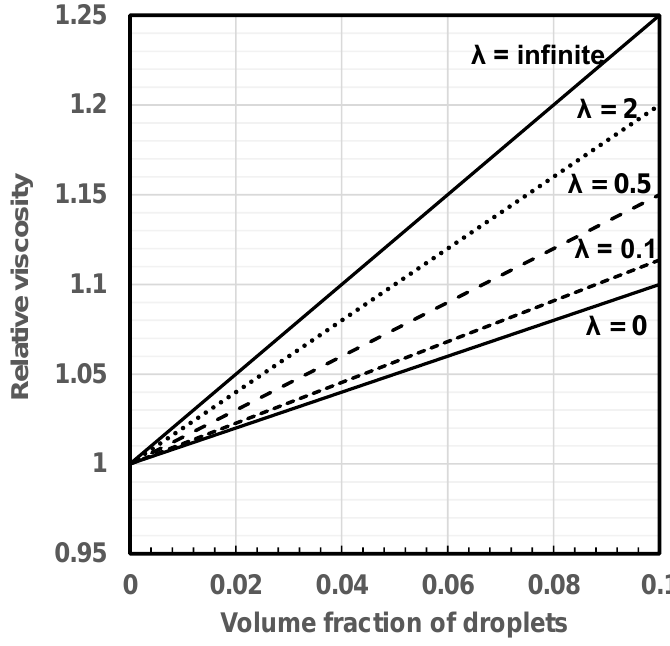
Figure 16. Relative viscosity η r versus droplet concentration φ for dilute emulsions for different values of the viscosity ratio λ .